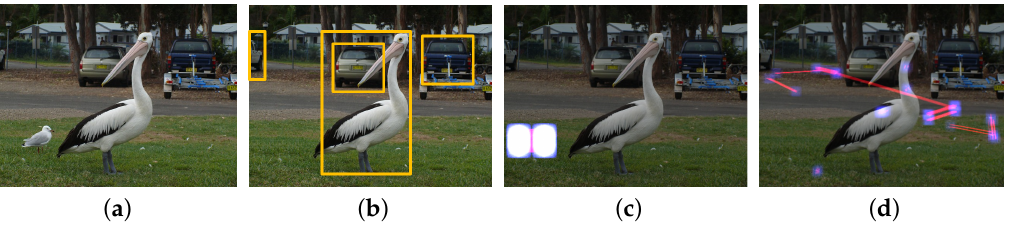
Figure 14. A part of grass image was copied and covered into the part of a seagull to make it disappear from the image. ( a ) Original image; ( b ) object detection result of the manipulated image; ( c ) detection result of the copy–move detector; ( d ) false positives of the detector on post-processed